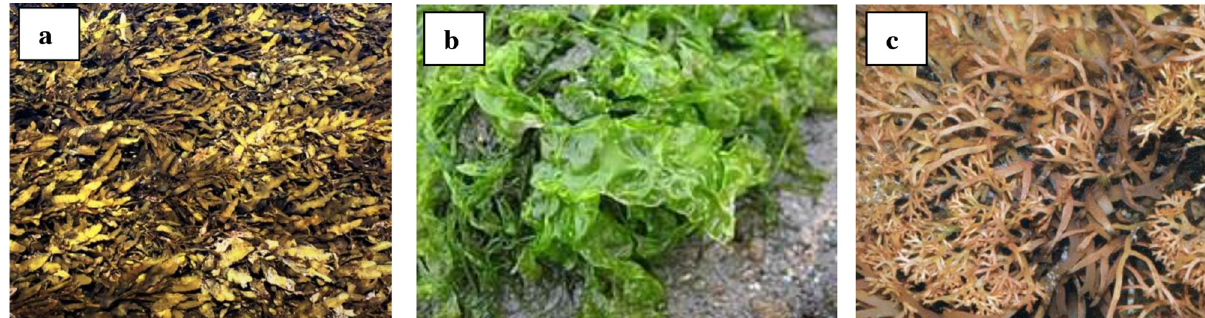
Fig. 2. Pictorial representation of varieties of seaweeds selected for the